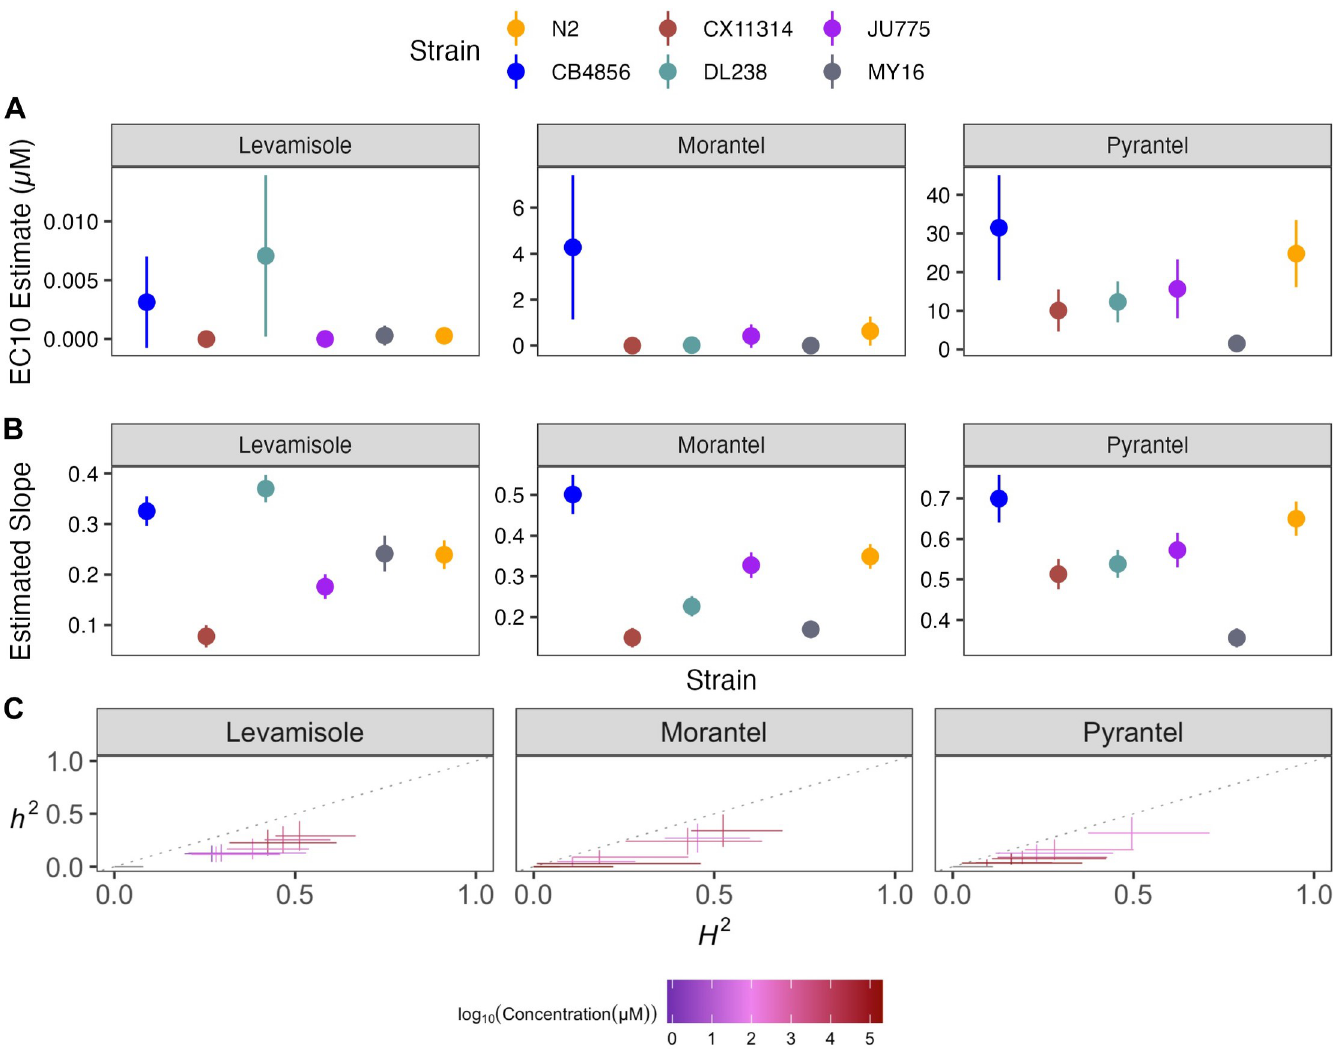
Fig 7. Variation in nicotinic acetylcholine receptor agonists (nAChR agonists) EC 10 dose-response and slope estimates can be explained by genetic variation across strains. (A) Strain-specific EC 10 estimates ( e ) for each nicotinic acetylcholine receptor agonist are displayed for each strain. Standard errors for each strain- and anthelmintic-specific EC 10 estimates are indicated by the line extending vertically from each point. (B) Strain-specific slope estimates ( b ) for each nicotinic acetylcholine receptor agonist are displayed for each strain. Standard errors for each strain- and anthelmintic-specific slope estimate are indicated by the line extending vertically from each point. (C) The broad-sense (x-axis) and narrow-sense heritability (y-axis) of normalized animal length measurements were calculated for each concentration of each nicotinic acetylcholine receptor agonist ( Methods ; Broad-sense and narrow-sense heritability calculations ). The color of each cross corresponds to the log- transformed dose for which those calculations were performed. The horizontal line of the cross corresponds to the confidence interval of the broad-sense heritability estimate obtained by bootstrapping, and the vertical line of the cross corresponds to the standard error of the narrow-sense heritability estimates.